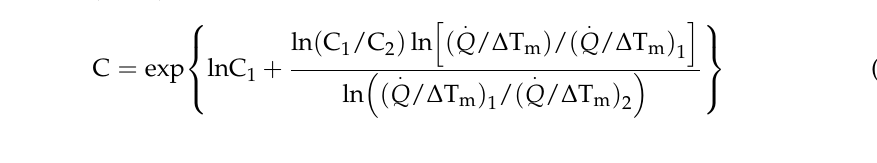
Table 4. U and C values for shell-and-tube heat exchangers (adopted from